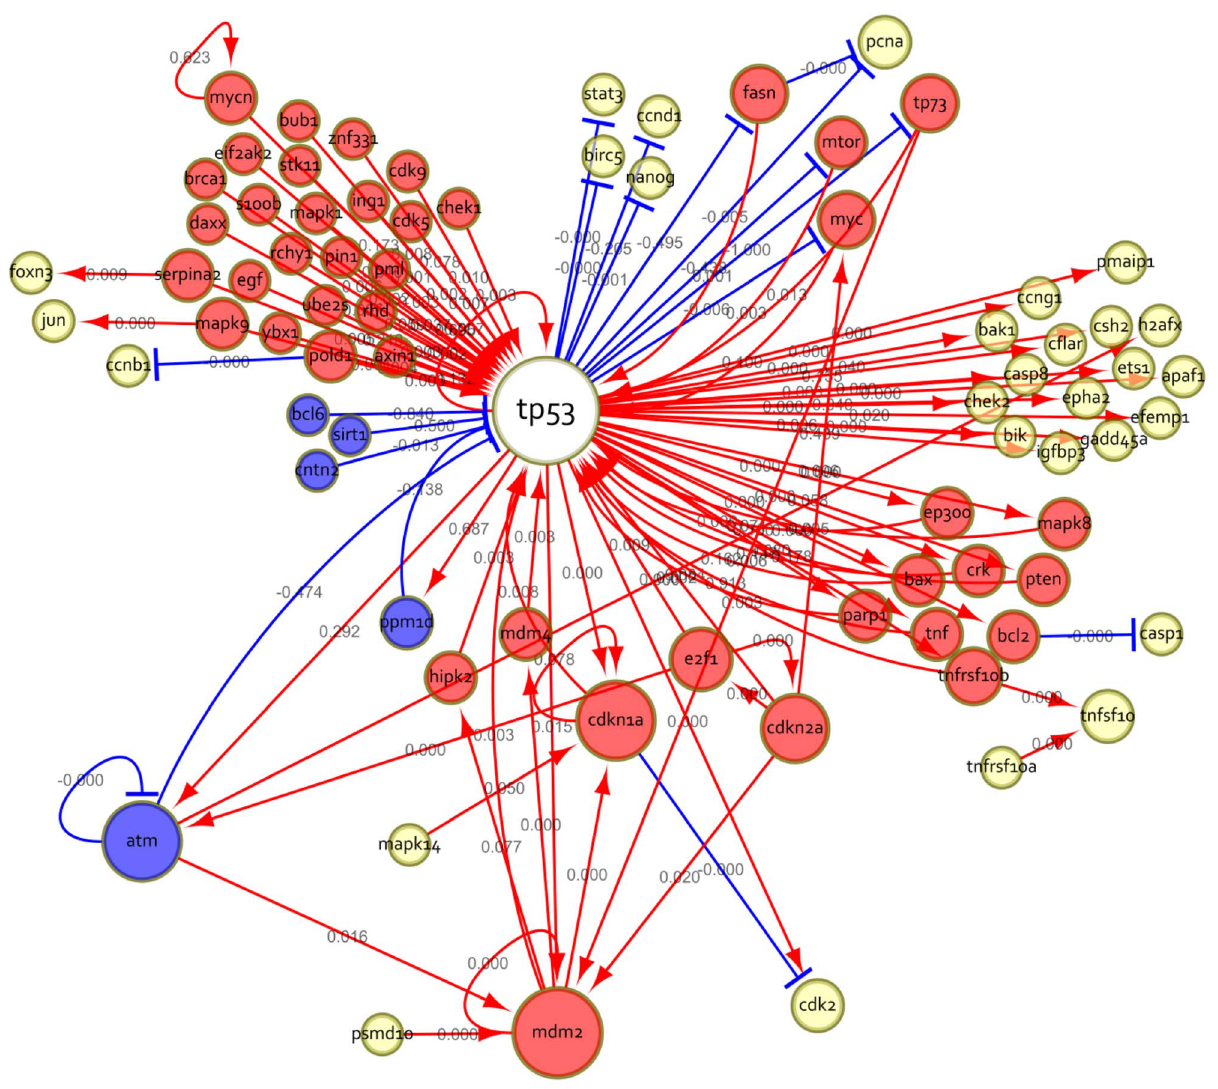
Figure 8. The resulting gene regulatory network for the p53 pathway. Interactions are defined by predications extracted from MEDLINE citations and weighted based on microarray data. Red node color signifies induction or activation of p53 while blue signifies suppression or deactivation and yellow indicates genes that do not act directly onto p53 . Red arrows show induction/activation. Blue arrows show inhibition. Size of a node corresponds to the number of connections to other